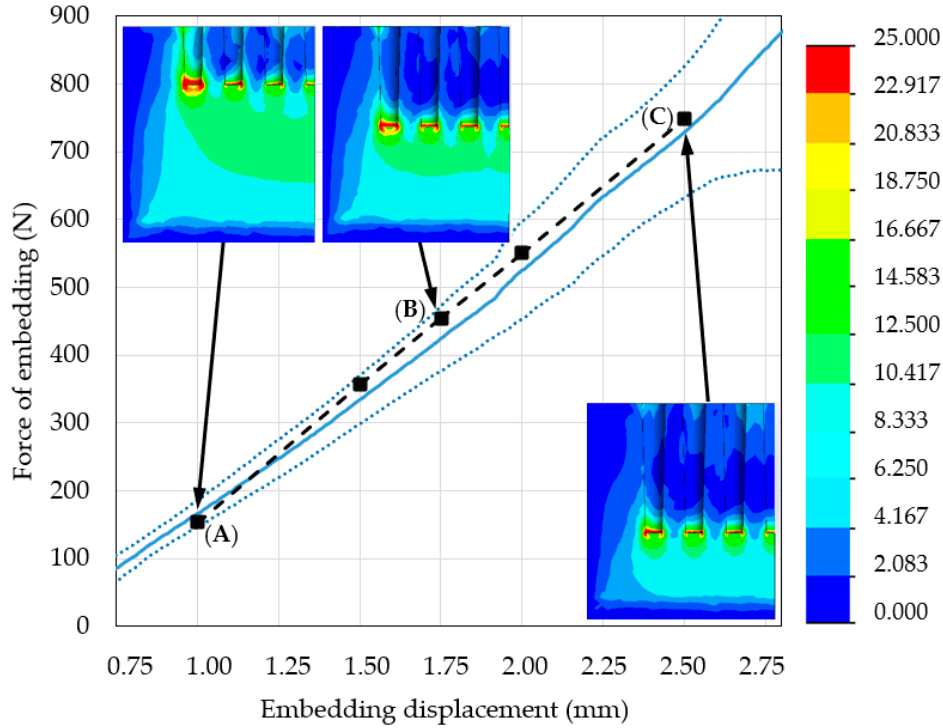
Figure 12. Region II of the force–distance curves obtained from experimental measurements (the mean line is presented as the solid blue line, dotted blue lines are ± standard deviations) and the results of re-simulations with FE model modified by the simulated insert of densified bone material (dashed black line) at (A) 1.00 mm embedding displacement and 153 N loading force; (B) 1.75 mm embedding displacement and 453 N loading force; (C) 2.50 mm embedding displacement and 748 N loading force.